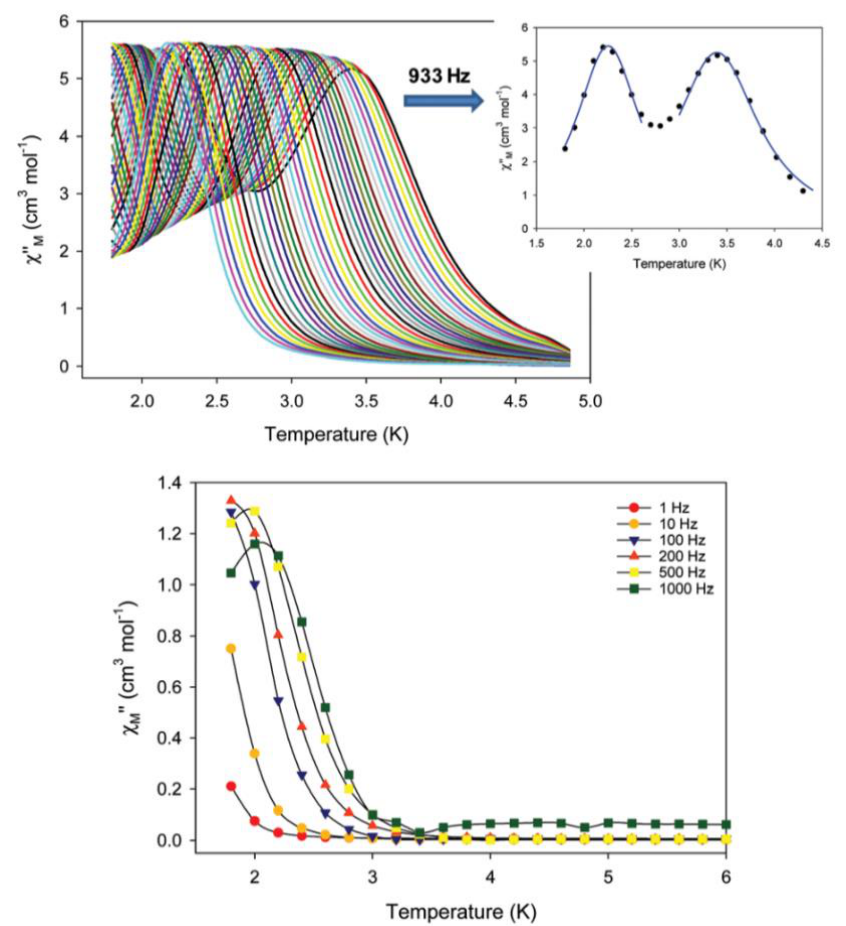
Figure 7. (Top) Out-of-phase ( χ ” M ) ac molar magnetic susceptibility signals for 7a . The inset shows the χ ” M vs. T plot at the representative ac frequency of 933 Hz revealing the two separation relaxation processes in two di ff erent T regions for the sample; the solid blue lines are the fits of the data. (Bottom) Frequency dependent χ ” M signals of 7 · 4MeCN. Reproduced from reference [70] with permission from the Royal Society of Chemistry.